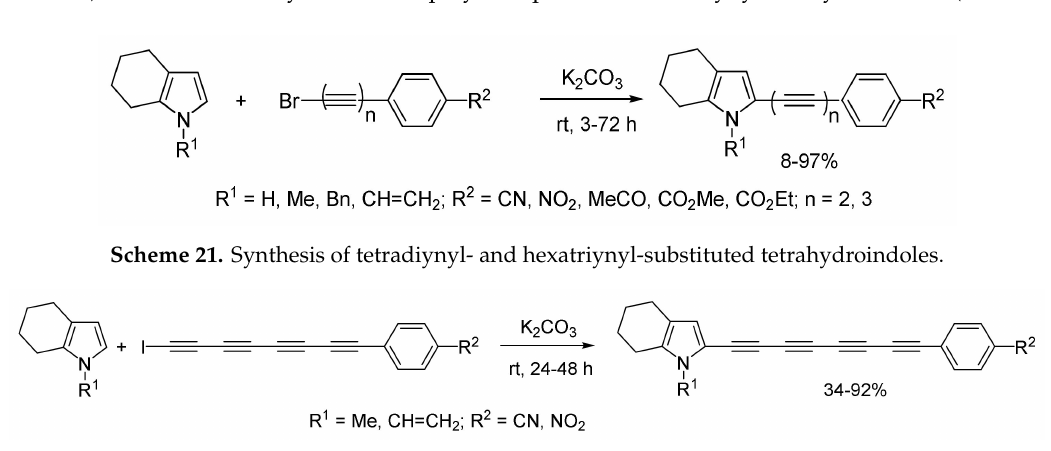
Scheme 22. Synthesis of octatetraynyl-substituted